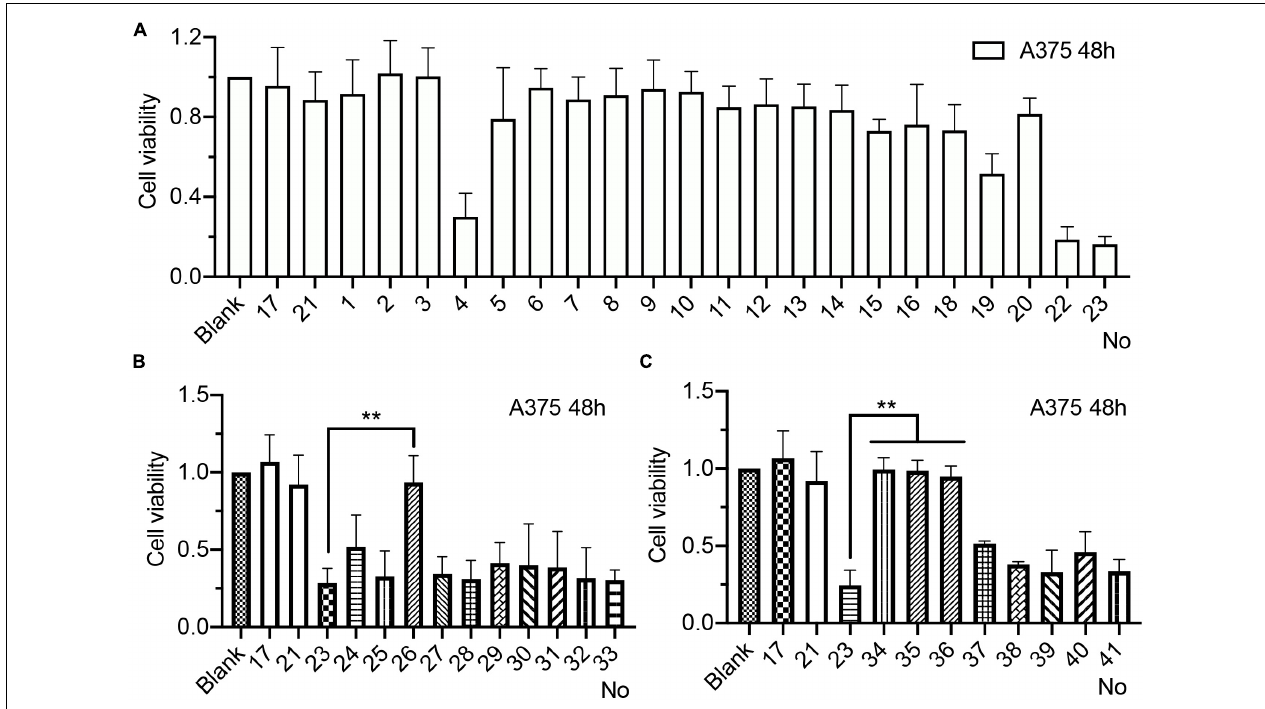
FIGURE 1 | Antiproliferation activity of chemical modified BC15-31s (DNCA/CLD/nt: 4:1:1.25 nM; 48 h) in A375 cell line. (A) Proliferation inhibitory effect of aptamer with PS modification. (B) Proliferation inhibitory effect of aptamer with LNA modification. (C) Proliferation inhibitory effect of aptamer with 2 (cid:48) - O -MOE modification. Numbers “1,” “2,” “3,” etc. correspond to the serial number in Table 1 . Experimented with CCK-8 reagent, ** P <